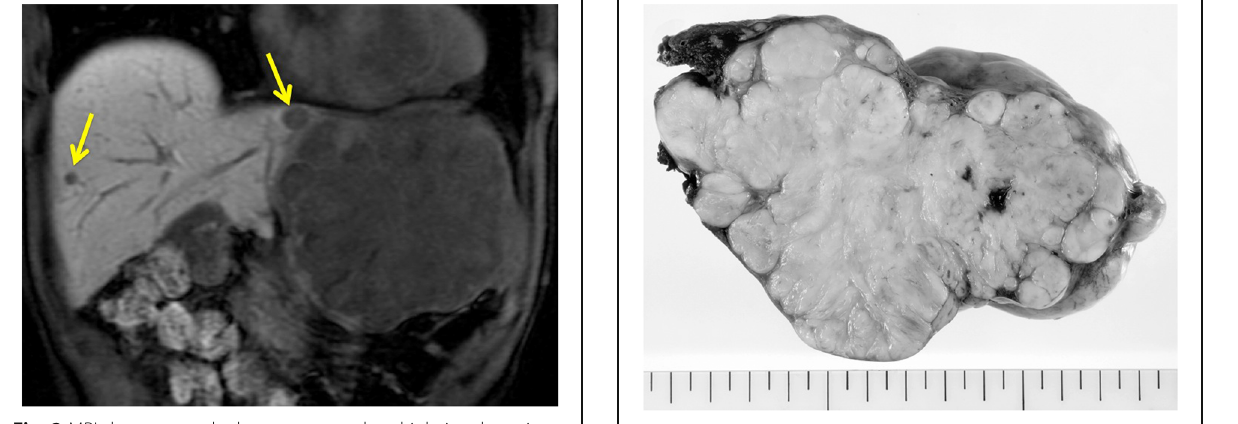
Fig. 4 Macroscopically, the lateral segment of the liver had been replaced by a lobular or multinodular tumor with a maximum diameter of 15 cm